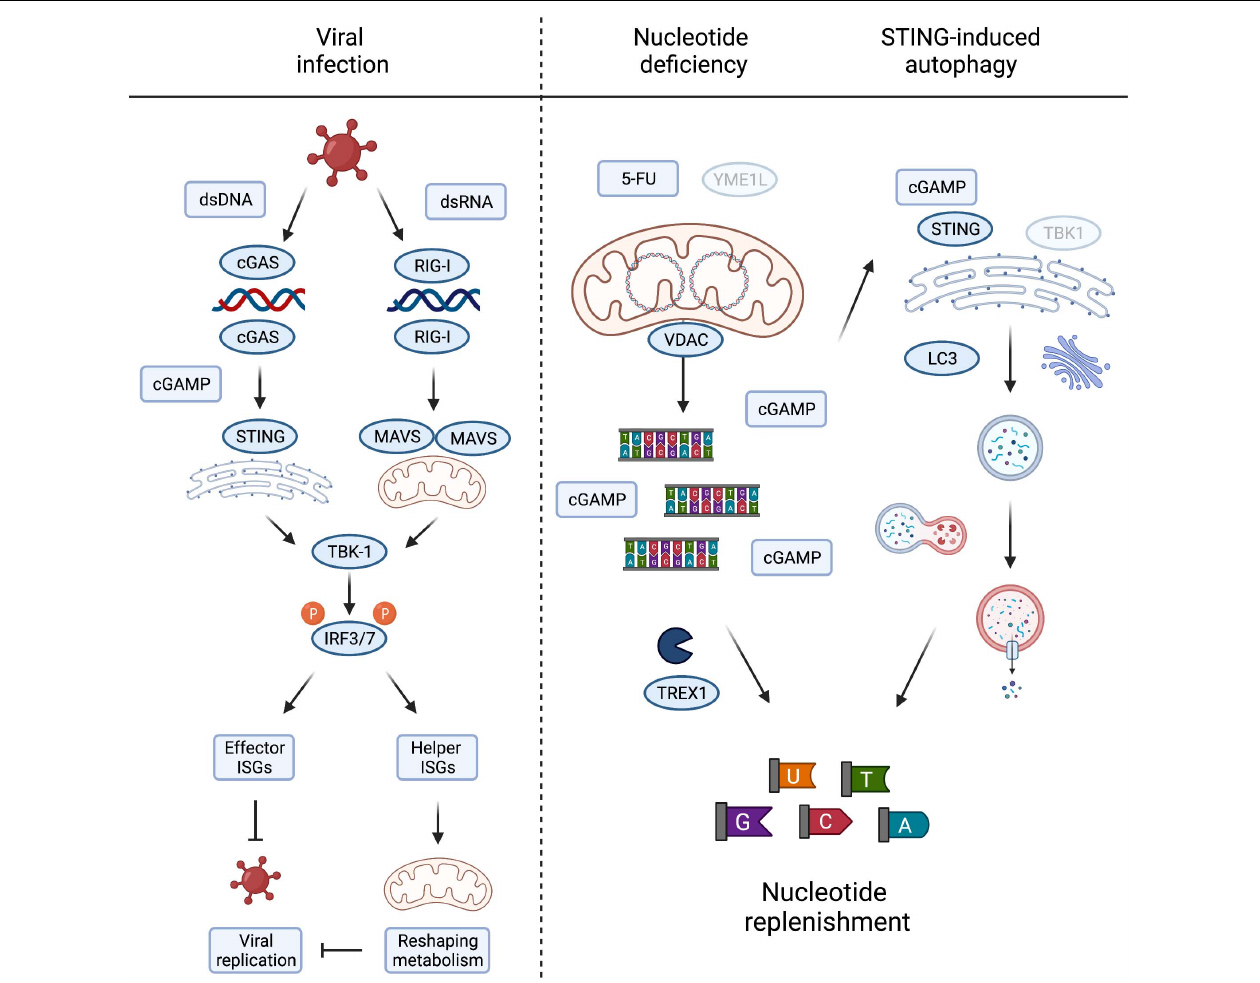
FIGURE 3 | Metabolic consequences of mtDNA release and innate immune signaling. Viral infection, either by DNA or RNA viruses, leads to the activation of TBK1 and subsequent phosphorylation of IRF3/7 to induce their nuclear translocation to activate type I interferons. The interferon stimulated genes (ISGs) prevent viral growth, either by direct inhibition of viral replication, termed here “effector ISGs,” or indirectly by rewiring mitochondrial and cellular metabolism (“helper ISGs”). The latter could be achieved by inducing metabolic conditions supporting/favouring the release of mtDNA (left panel) . Nucleotide deficiency induced by loss of YME1L or treatment with thymidylate synthase (TS) inhibitor 5-FU leads to the release of mtDNA. TREX1 competes with cGAS for the binding and degradation of mitochondrial dsDNA to single nucleotides, replenishing cellular nucleotide pools in the process. cGAS binding of mtDNA generates cGAMP to